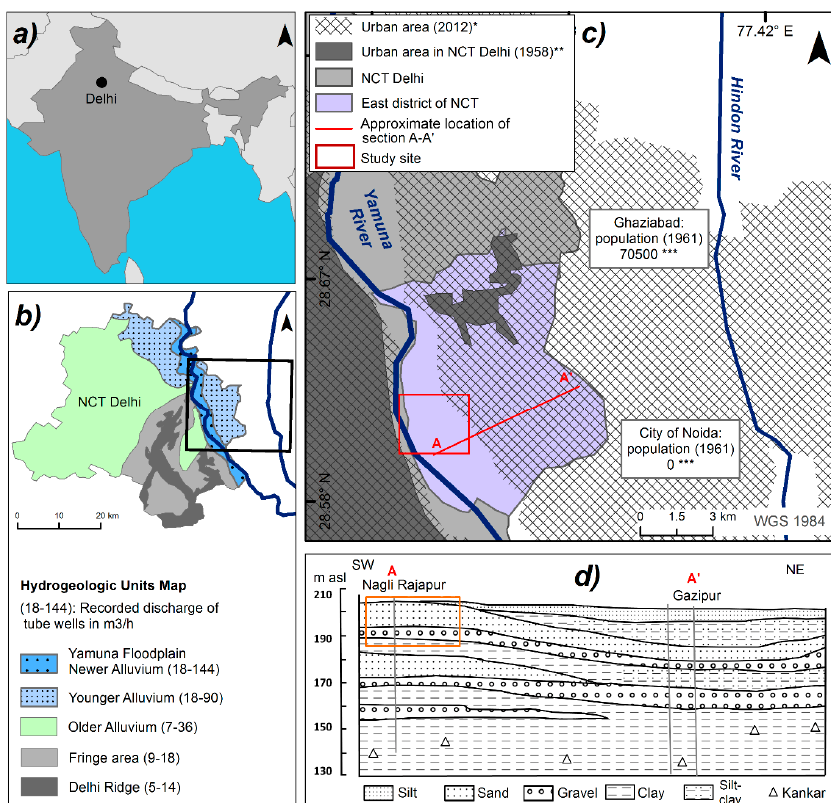
Figure 1. ( a ) Location of Delhi. ( b ) Hydrogeologic units of the National Capital Territory (NCT) of Delhi and data frame of Figure 1c (map modified after [16]). Discharge of the tube wells compiled from [16,17]. ( c ) Population development in the eastern part of Delhi, Ghaziabad, and Noida, and the location of the study area (red box) (* data from [2]; ** modified after [18]; *** [19]) ( d ) SW-NE vertical cross section through East Delhi (location shown in ( c )). The orange box represents the approximate position of the study area (modified after